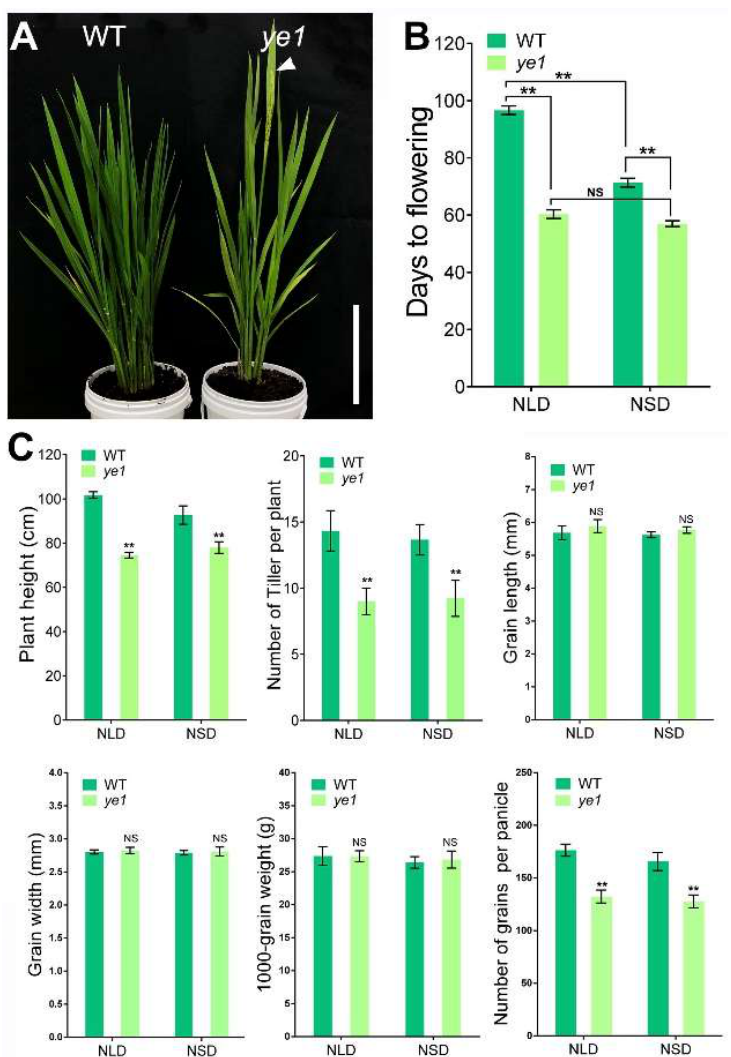
Figure 2. Flowering time phenotypes and other agronomic traits of WT and ye1 . ( A ) Phenotype of WT and ye1 under NLDs, when ye1 was heading. The arrow indicates the flower. Bar = 25 cm. ( B ) Days to flowering of WT and ye1 under NLDs and NSDs (mean ± SD, n = 3). NS, no significant change. Significant differences were shown as ** ( p < 0.01) by Student’s t -test ( C ) Other agronomic traits (including plant height, tillering number, grain length, grain width, 1000-grain weight, and number of grains per panicle) of WT and ye1 under NLDs and NSDs. Each value is given as means ± SD ( n = 3). NS, no significant change. ** ( p < 0.01) indicate significant differences between WT and ye1 (Student’s t -test).